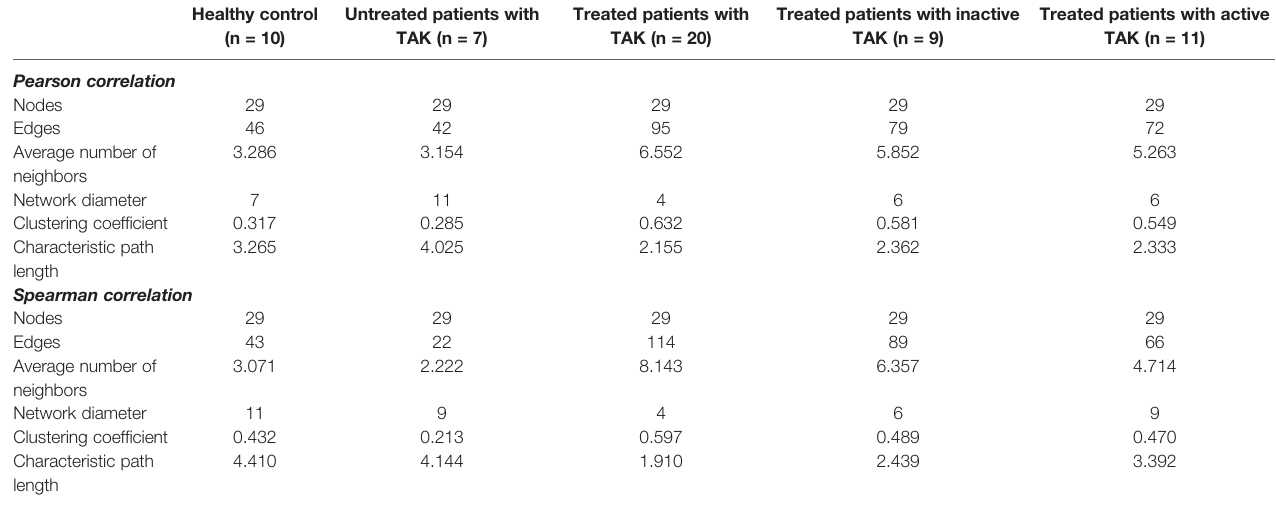
TABLE 2 | Parameters of gene co-expression networks. Healthy control (n =